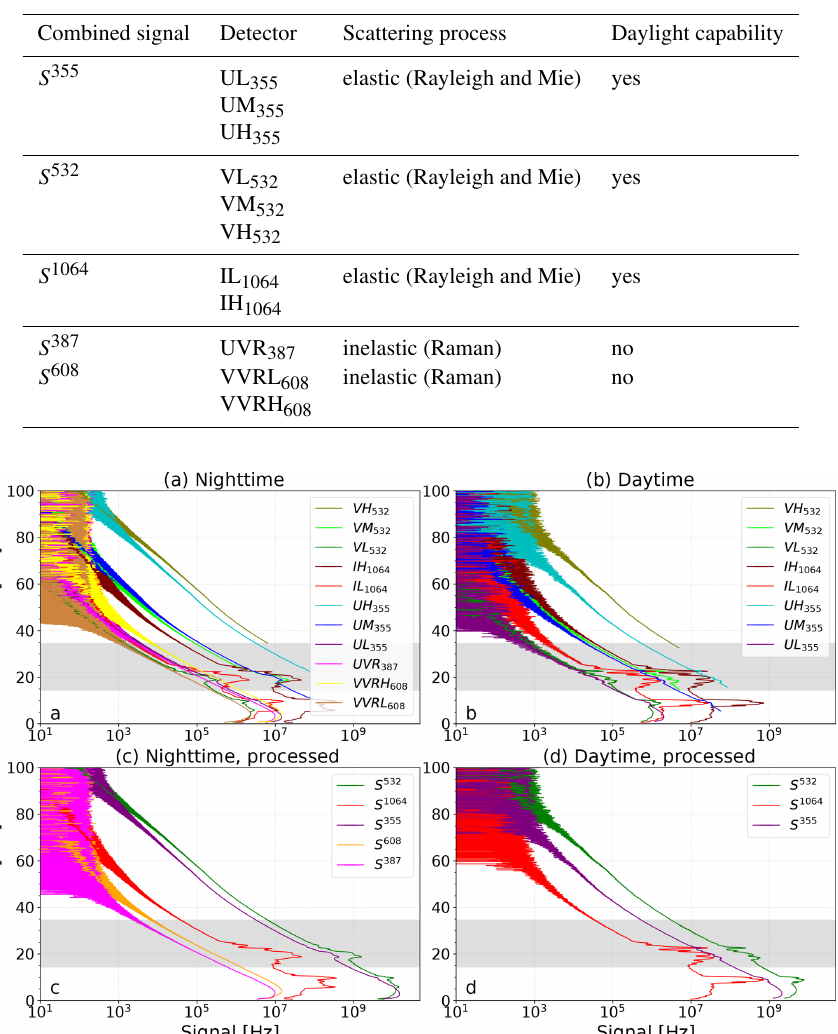
Figure 2. Time averaged altitude profiles of backscattered signals for a 17h long measurement starting at 13:00UT on 27 January 2018. Panels (a) and (b) show the count rates of individual detectors. Panels (c) and (d) show the resulting profiles after combining the signals of the different detector groups. Panels (a) and (c) show about 10h of nighttime measurements and panels (b) and (d) show about 7h of daytime measurements. The approximate altitude range of the stratospheric aerosol layer is shown in